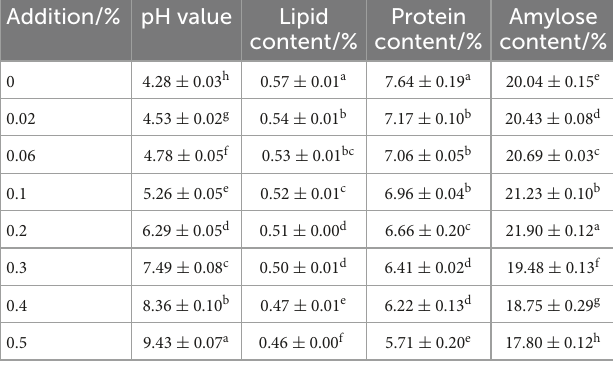
TABLE 1 Effect of sodium bicarbonate on the basic physicochemical composition of rice flour. Addition/% pH value